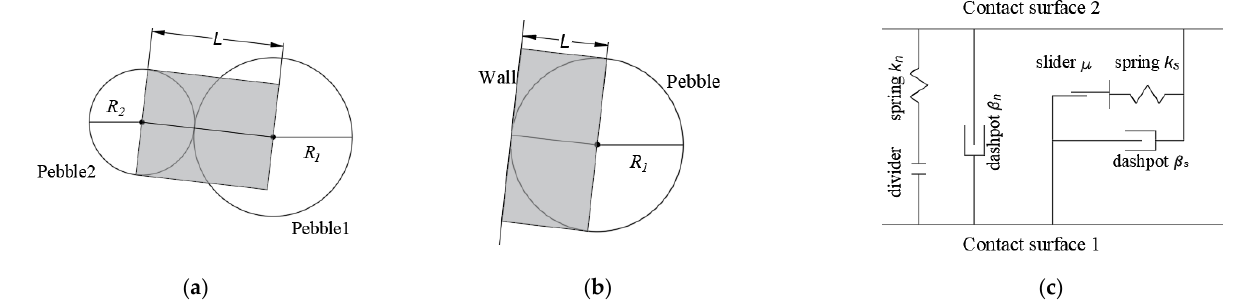
Figure 3. Geometric parameters and rheological components of the linear contact model. ( a ) Particle–particle contact; ( b ) particle–wall contact; ( c ) rheological model.